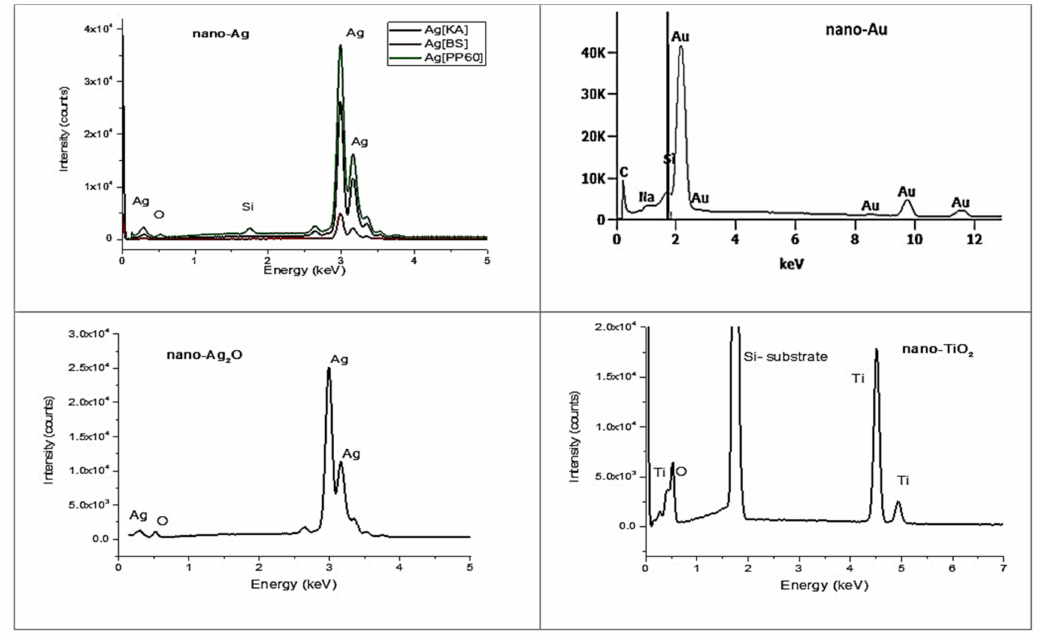
Figure 8. EDS spectra of nano-Ag: Ag[KA], Ag[BS], and Ag[PP60], nano-Au, nano-Ag 2 O, and nano- TiO 2